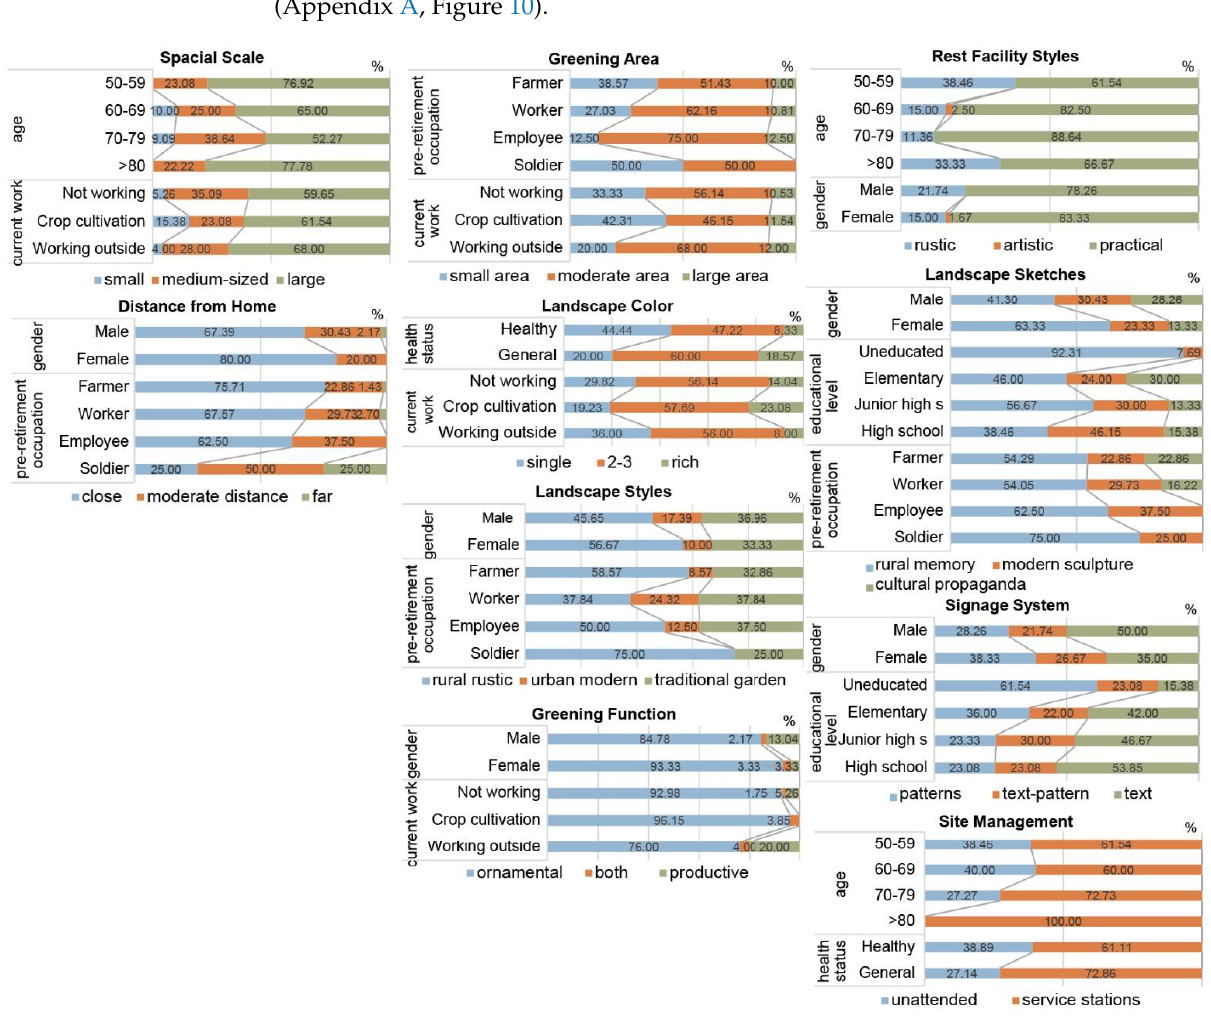
Figure 10. Relationship between personal attributes and spatial preferences — part